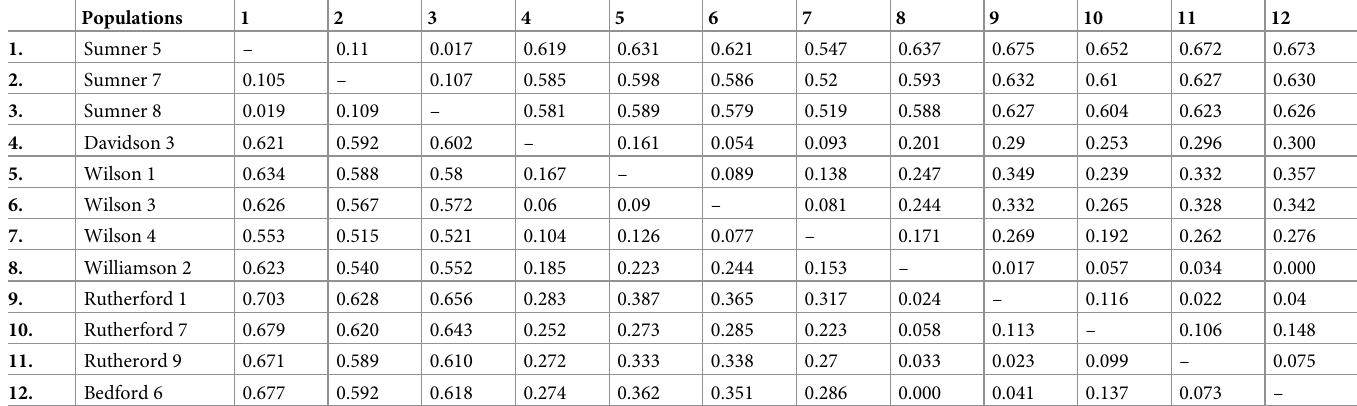
Table 5. Population pairwise F ST estimates (above diagonal) and G” ST (below diagonal) averaged across 584 SNP loci for 12 populations of Ambystoma barbouri in Tennessee.